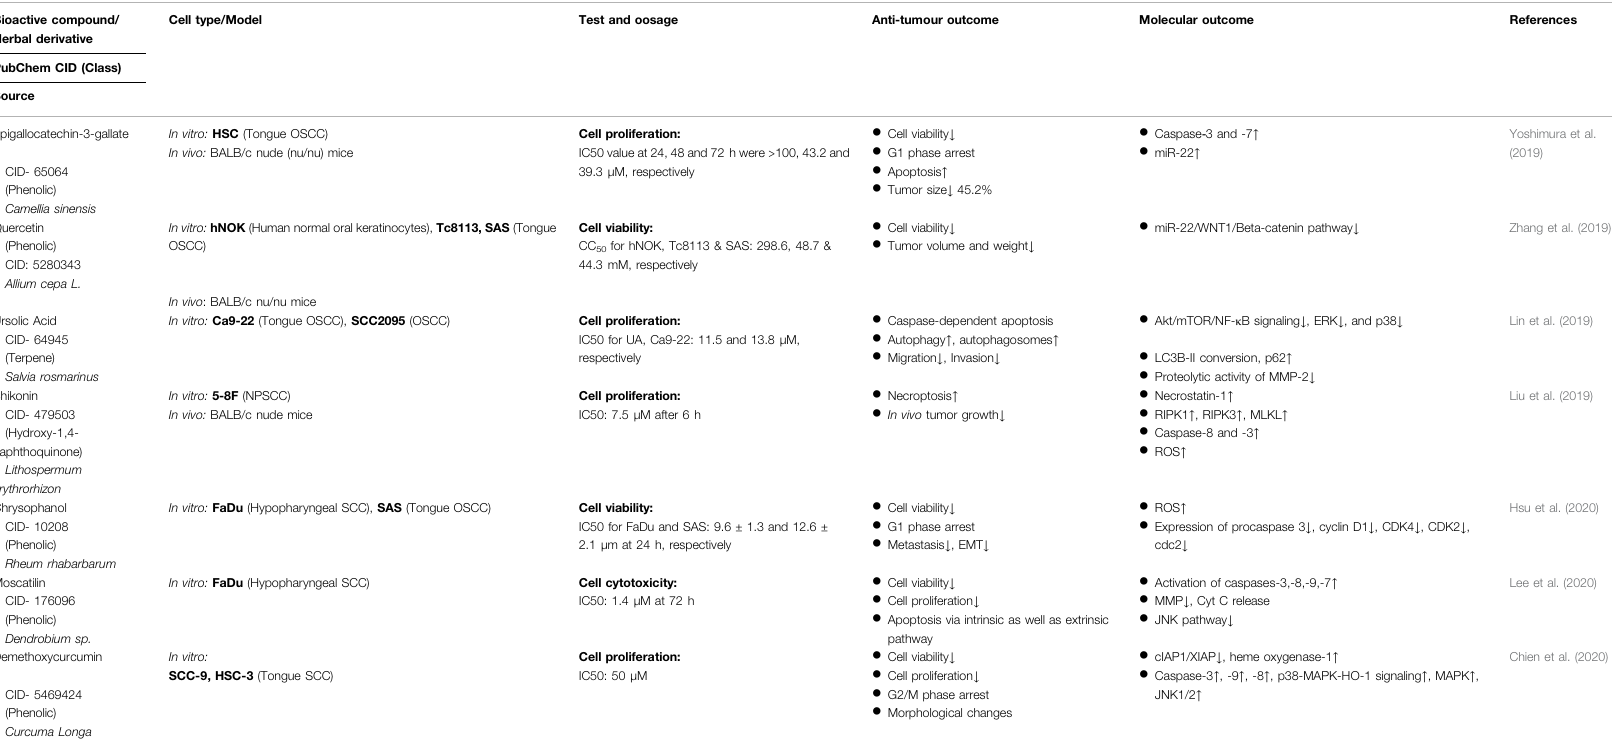
TABLE 4 | ( Continued ) Preclinical studies showing therapeutic phytochemicals/herbal derivatives against tobacco/alcohol-associated